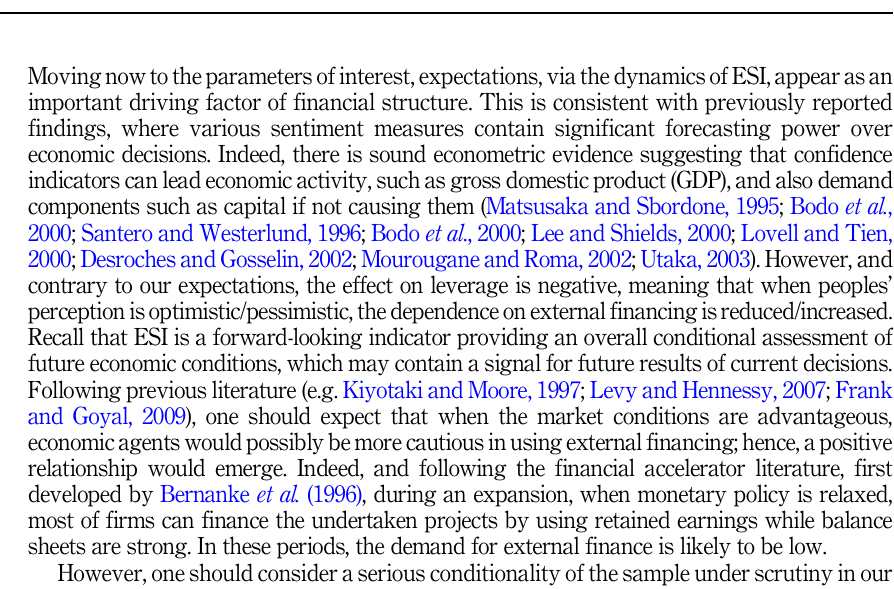
Table 3. Estimation